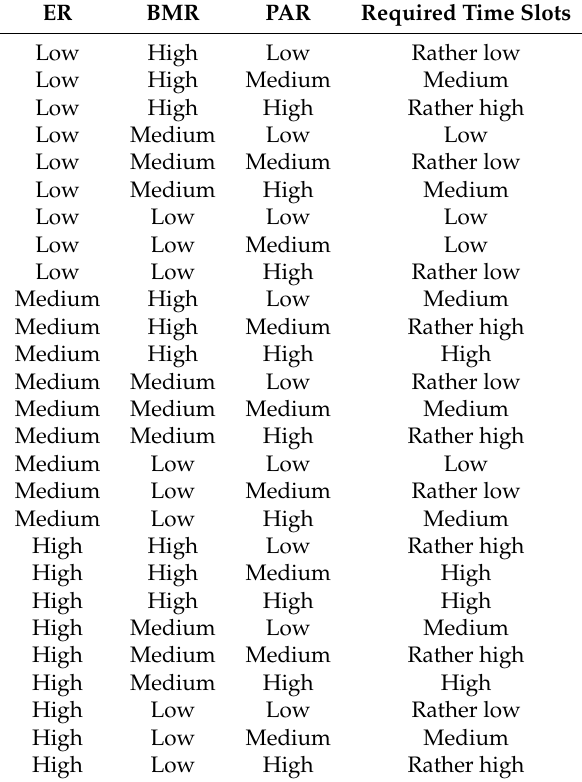
Table 1. Fuzzy inference